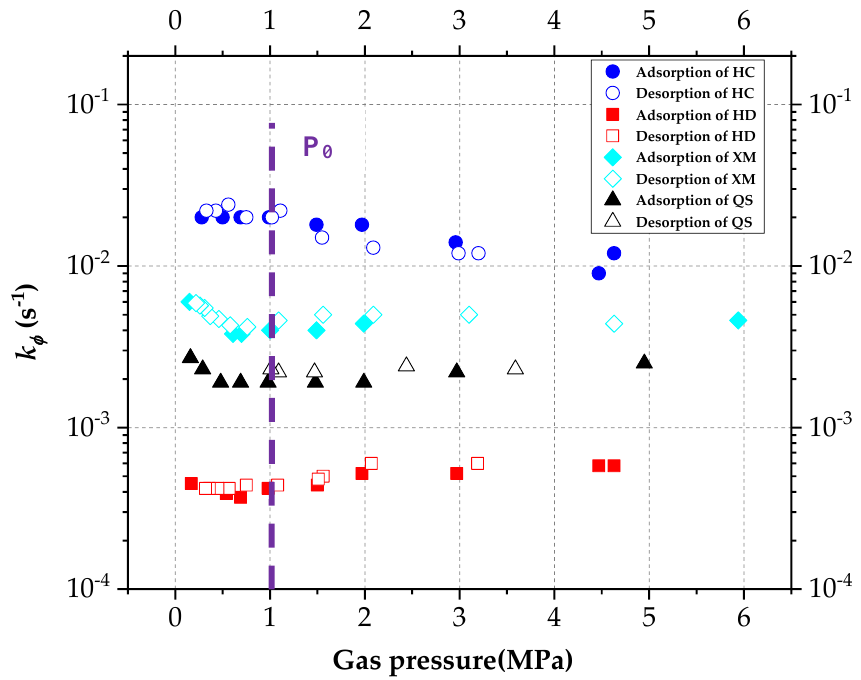
Figure 8. The diagram of variation of characteristic rate parameter k Φ with pressure.